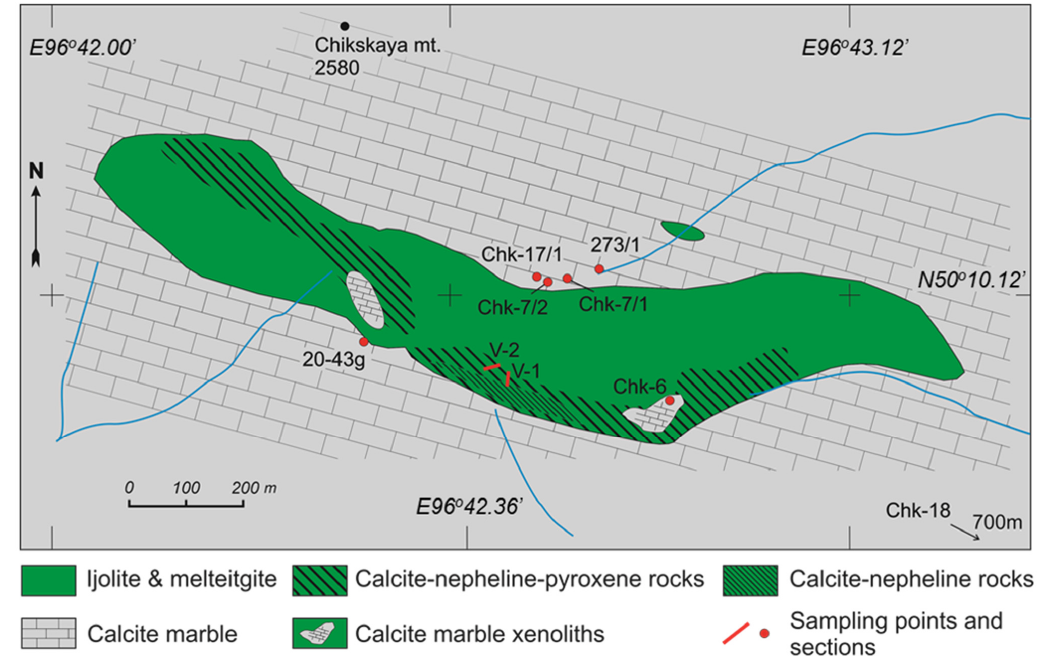
Figure 2. A simplified geological map of the Chik intrusion.